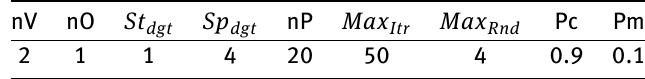
Table 7: VSSCGA Settings for Ackley’s function with 2 variables